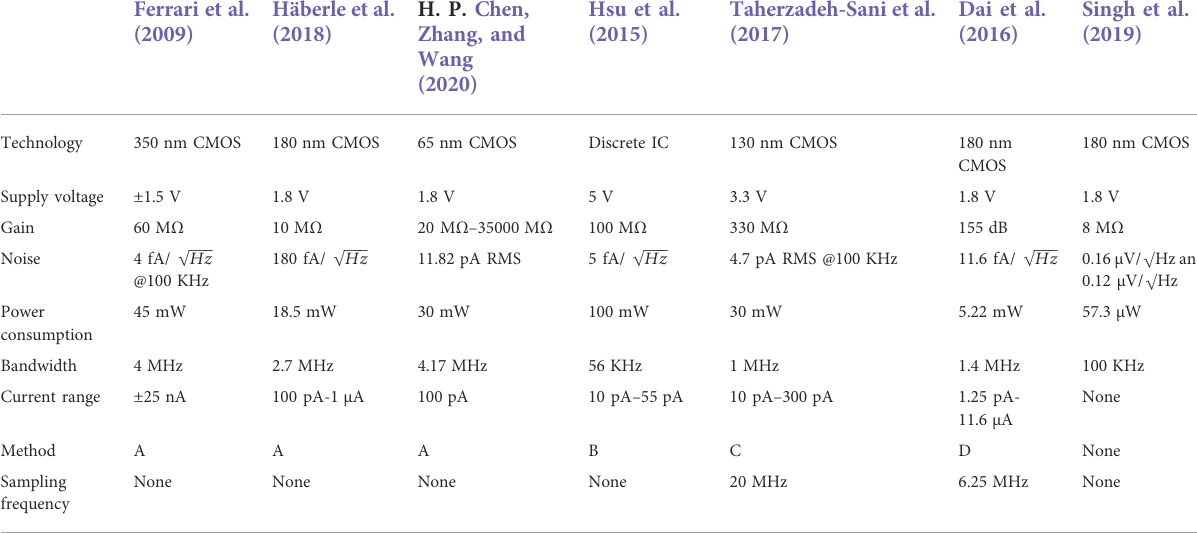
TABLE 3 Performance, summary, and comparison of previous works using the CT approach. Ferrari et al.